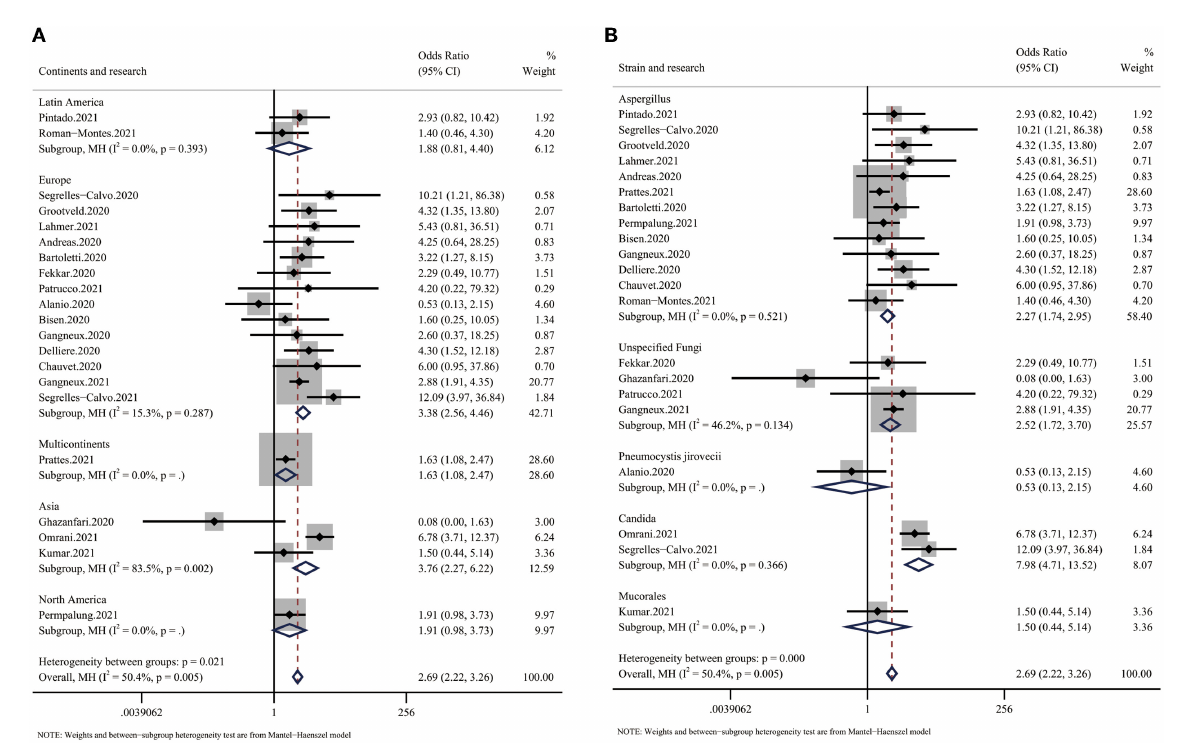
FIGURE3 Forest plot showing the results of the subgroup analysis. (A) Forest plot of the OR for mortality in CMI patients compared with non-CMI patients on different continents. The OR for Europe was 3.38 (95% CI: 2.56–4.46), the OR for Asia was 3.76 (95% CI: 2.27–6.22), and the OR for Latin America was 1.88 (95% CI: 0.81–4.40). (B) Forest plot of the OR for mortality in COVID-19 patients infected with different species of fungi. The OR for COVID-19 in patients with Aspergillus infection was 2.27 (95% CI: 1.74–2.95), the OR for COVID-19 in patients with Candida